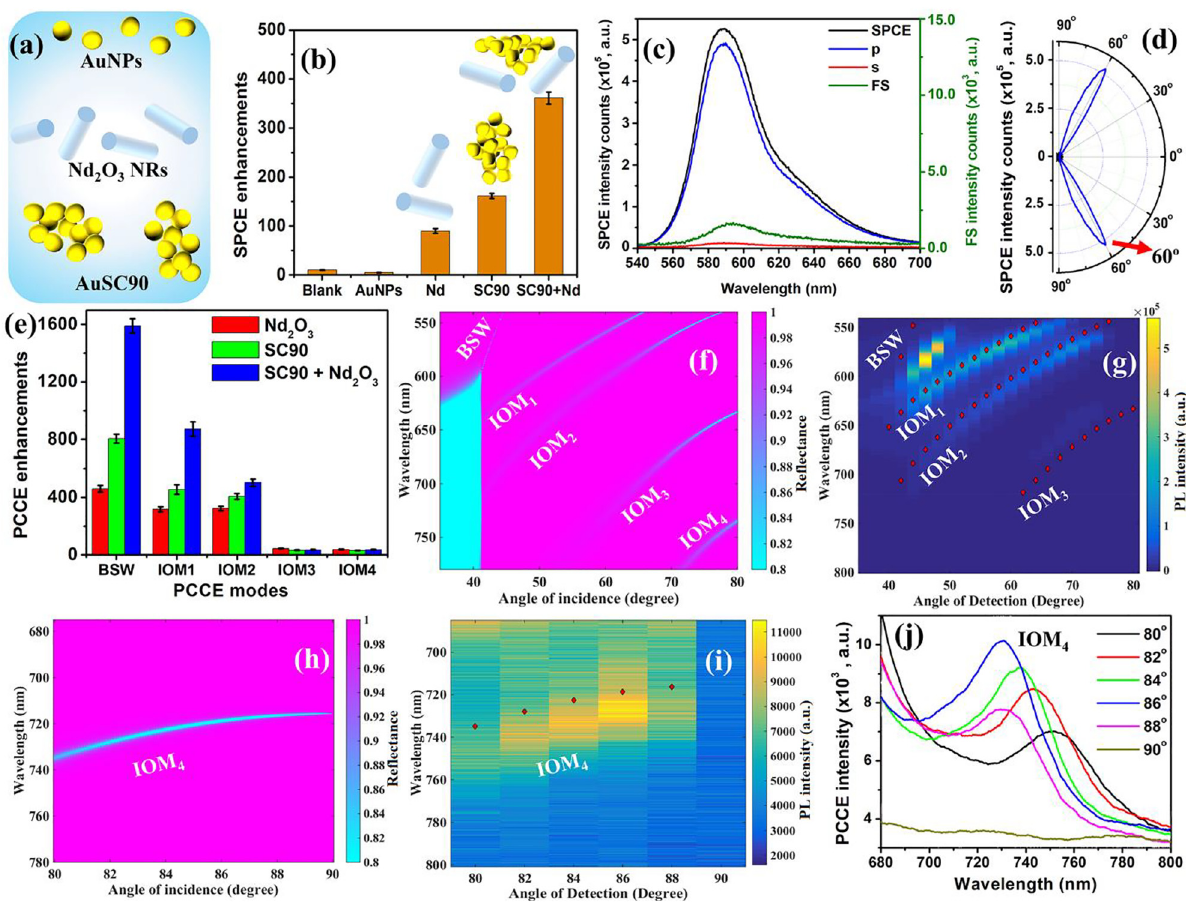
Figure 5: (a) Conceptual schematic of AuNPs, Nd 2 O 3 NRs, AuSC90. (b) SPCE enhancements for blank, AuNPs, Nd 2 O 3 NRs (Nd), SC90 and mixture of SC90 and Nd in cavity nanointerface. (c) SPCE, Free Space (FS), p -polarized ( p ) and s -polarized ( s ) emission spectra for sample (SC90 + Nd) presenting maximum enhancements in (b). (d) The corresponding angularity plot (of c) presenting highly directional emission characteristic. (e) PCCE enhancements for different modes (BSWs, IOM 1 , IOM 2 , IOM 3 and IOM 4 ) for Nd 2 O 3 , SC90 and SC90 + Nd 2 O 3 samples. (f)Numericaldispersiondiagramintheangularrangefrom35 ° to80 ° .Thecolorbarrepresentsthere fl ectanceinarbitraryunits.(g)Dispersion diagram presenting overlap of numerical (dotted line) and experimental data for 60 nm PVA doped SC90 + Nd 2 O 3 in PCCE platform. (h) Numerical dispersion diagram in the angular range from 80 ° to 90 ° . (i) Dispersion diagram presenting overlap of numerical and experimental data for use of 60 nm PVA doped SC90 + Nd 2 O 3 in the angular range from 80 ° to 90 ° . (j) The angular sweep from 80 ° to 90 ° for SC90 + Nd 2 O 3 in PCCE platform. All the remaining PCCE spectra are presented elaborately in SI. In (f) and (h), the color bar represents the re fl ectance in arbitrary units. In (g) and (i) the color bar represents fl uorescence intensity in arbitrary units. The red dots correspond to the locations of BSW and IOMs from the numerically calculated dispersion